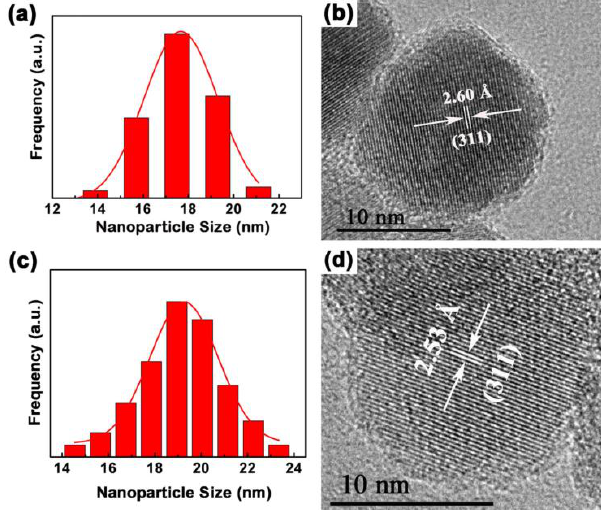
Figure 6. TEM analyses of ( a ) Fe 3 O 4 and ( c ) Fe 3 O 4 @1 fitted by a Gaussian function; ( b ) HRTEM of Fe 3 O 4 and ( d ) Fe 3 O 4 @1 .